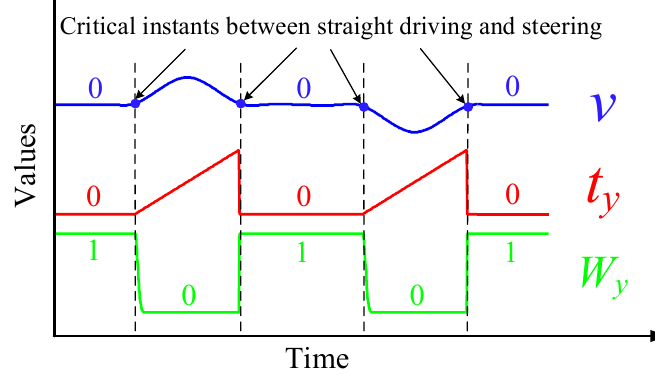
Figure 4. The value of W x with varying lateral velocity.